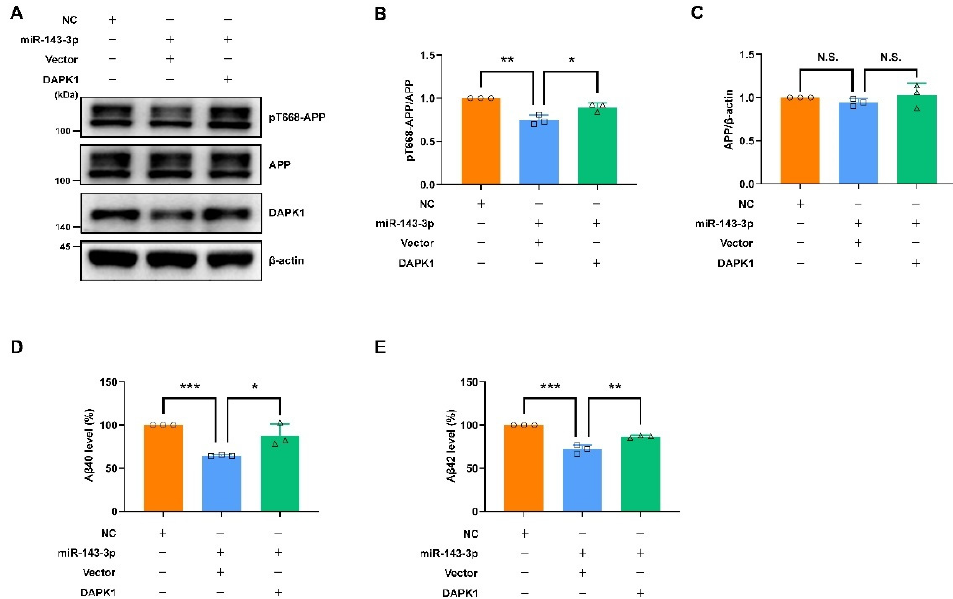
Figure 8. Restoring DAPK1 antagonizes the effects of miR-143-3p in reducing APP phosphorylation and A β secretion. ( A – C ) SH-SY5Y APP cells were transfected with NC, miR-143-3p alone or miR-143-3p together with a plasmid encoding human DAPK1 for 48 h, and the levels of APP phosphorylated at Thr668, total APP, and DAPK1 were analyzed by immunoblotting. ( D , E ) SH-SY5Y APP cells were transfected with NC, miR-143-3p alone or miR-143-3p together with a plasmid encoding human DAPK1 for 48 h, and the levels of human A β 40 ( D ) and A β 42 ( D ) in cell culture supernatants were determined by solid-phase sandwich ELISA. Relative quantification was performed using ImageJ software, and the results are presented as a histogram. The data (circles, squares and triangles) are presented as the mean ± SD of three independent experiments (* p < 0.05, ** p < 0.01, *** p < 0.001, N.S., not significant).